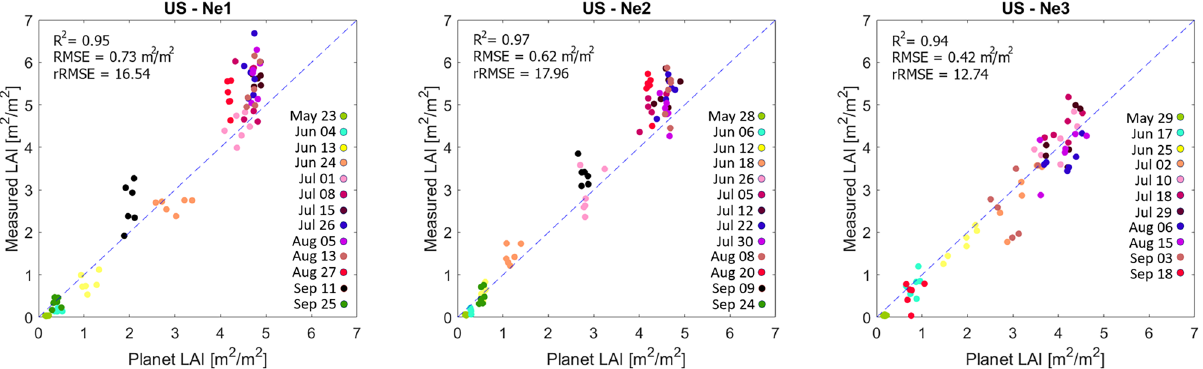
Figure 3. Scatterplots between field-measured LAI and LAI estimates of 7 × 7 pixels derived from the corresponding locations of the Planet CubeSat data collected 13 times during the growing season for US-Ne1 and Ne2 and 11 times for the US-Ne3 maize